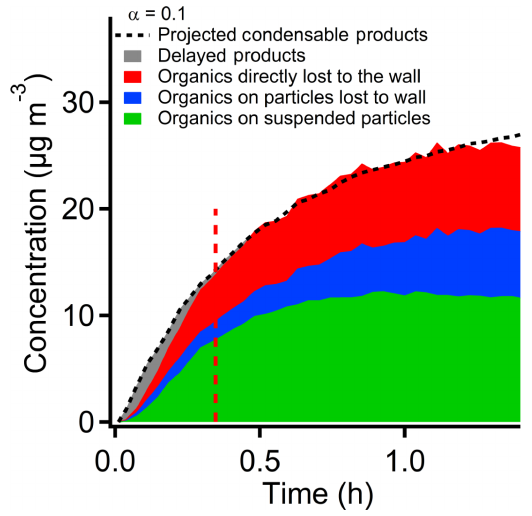
Figure 8. The discrepancy of the observed SOA caused by the con- densation delay. The black dash line shows the estimated concen- tration of condensable vapors from the reacted PD. The dashed area at 0–0.3h shows the difference between formed vapors and the ob- served SOA. This gap may be caused by the diffusion time of vapor molecules to reach the surface of the particles or the chamber walls. This delay may result in a lower measured SOA mass yield at the early stage of the